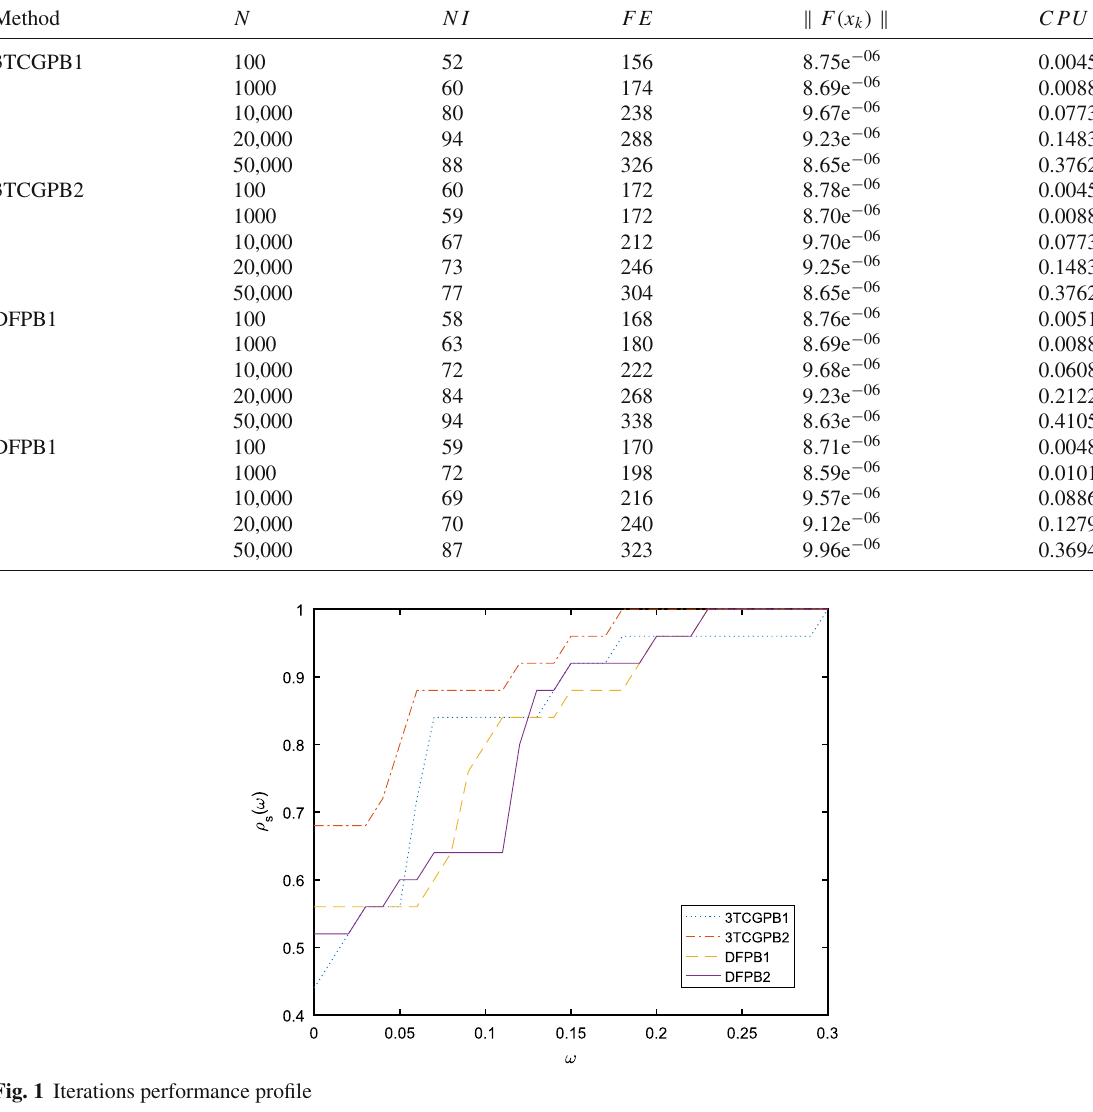
Table 5 Numerical results of Problem 4.5